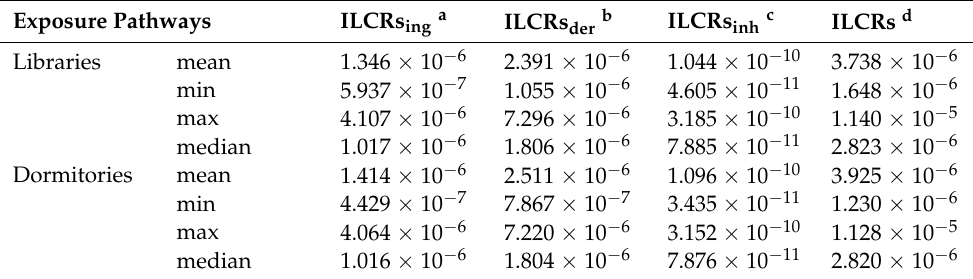
Abbreviations: a the values of cancer risks derived from PAHs via ingestion. b the values of cancer risks derived from PAHs via dermal contact. c the values of cancer risks derived from PAHs via inhalation. d the sum of the risks of the above three exposure